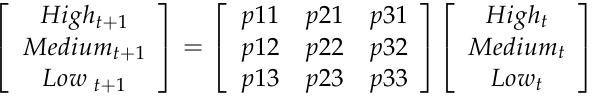
Figure 5. Possible transitions between High, Medium, and Low consumption.